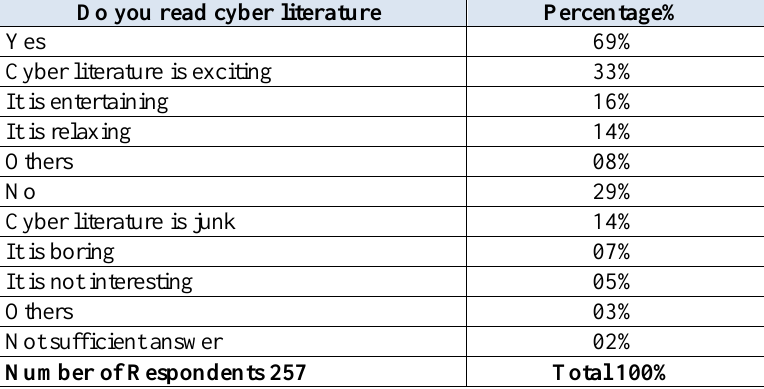
Table 1. Response of the